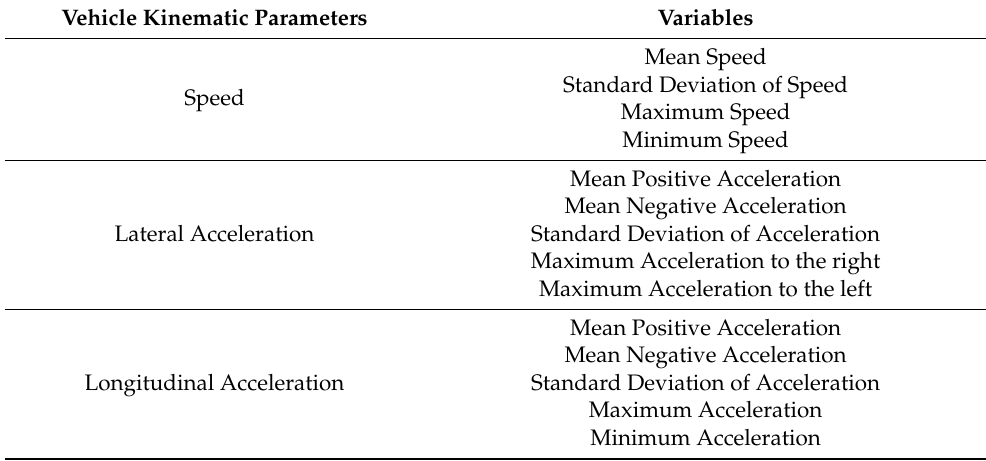
Table 2. Variables aggregated for cluster analysis. (Adapted from Chen, K.-T.; Chen, H.-Y.W.